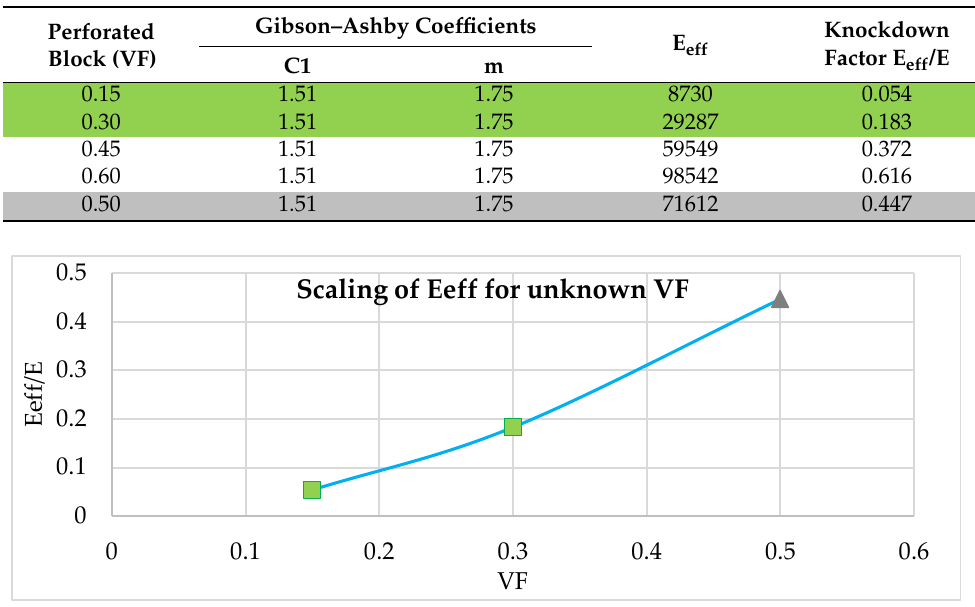
Table 6. VF of homogenized model scaled using the Gibson–Ashby model for perforated block support.